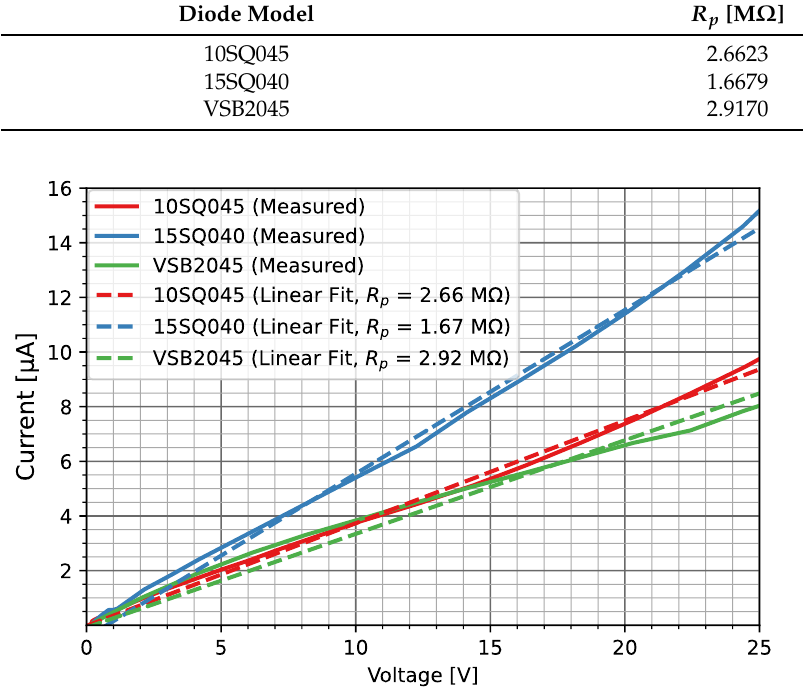
Figure 20. Linear fit of R p for small negative DC voltages for the three diodes.